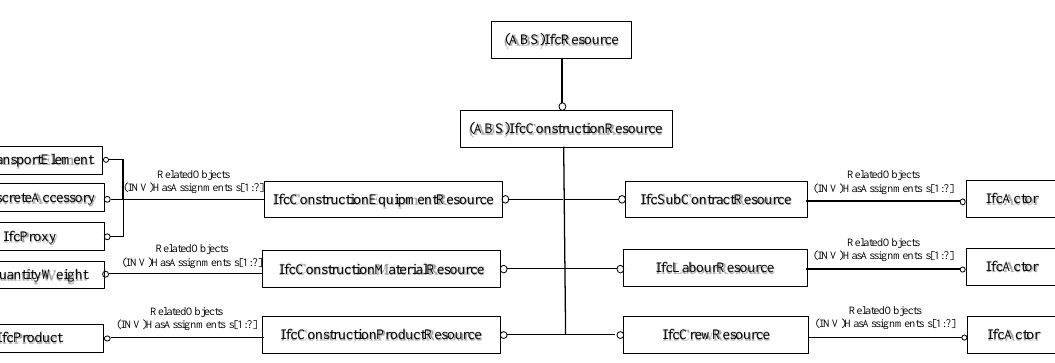
Figure 2. Process information’s extension model.